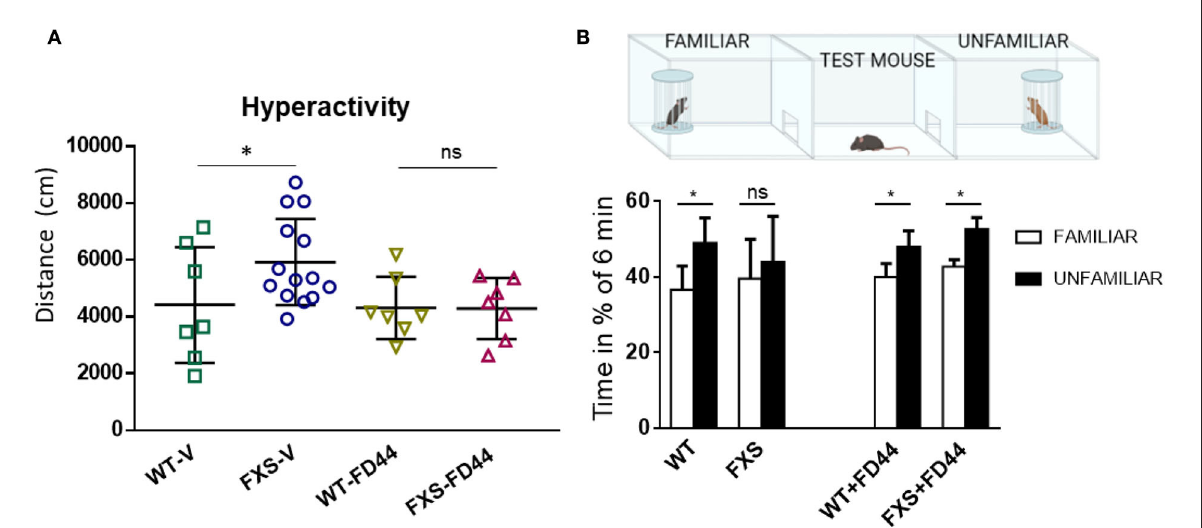
FIGURE4 FD44 effects on hyperactivity and social approach in Fmr1 KO mice. WT or Fmr1 KO (FXS) adult mice were treated intraperitoneally for 4 weeks, with V or with 10 mg/kg FD44. (A) An open field test was performed. Hyperactivity, measured as the traveled distance, was significantly higher in the V-treated FXS compared to WT. (B) A three-chamber social test was performed, as indicated in the picture. Bars represent the mean percentage of time the test mice in each group spent in the right chamber with the familiar mouse (white column) vs. the percentage of time in the left chamber with the unfamiliar mouse (black column). Untreated FXS mice showed a nonsignificant (ns) preference. Data were analyzed by one-way ANOVA followed by Bonferroni multiple pair-wise comparison. n = 7 (WT-V), 14 (FXS-V), 7 (WT-FD44), and 7 (FXS-FD44), only relevant comparisons are shown, * p < 0.05 and ns =